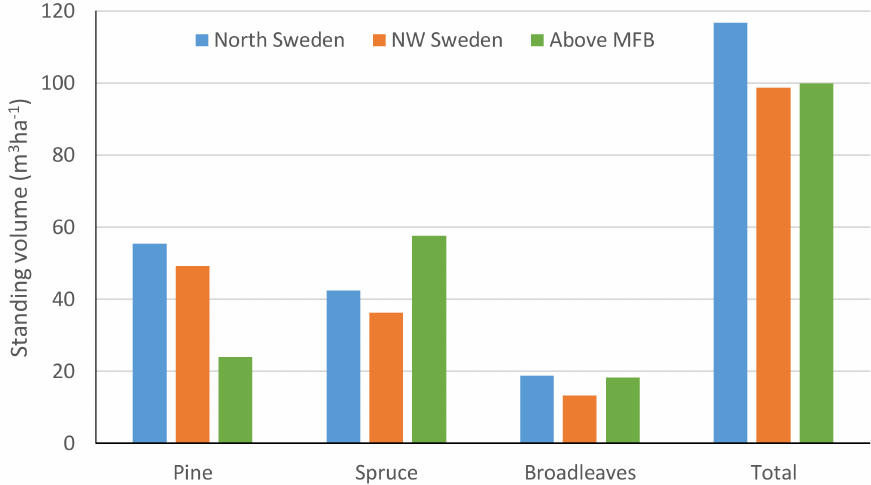
Figure 4. Standing volume of living trees per hectare based on the Swedish National Forest Inventory (5-year average) for all forests in north Sweden, mountain municipalities (NW Sweden) and the area above the mountain forest border. Only forests outside protected areas